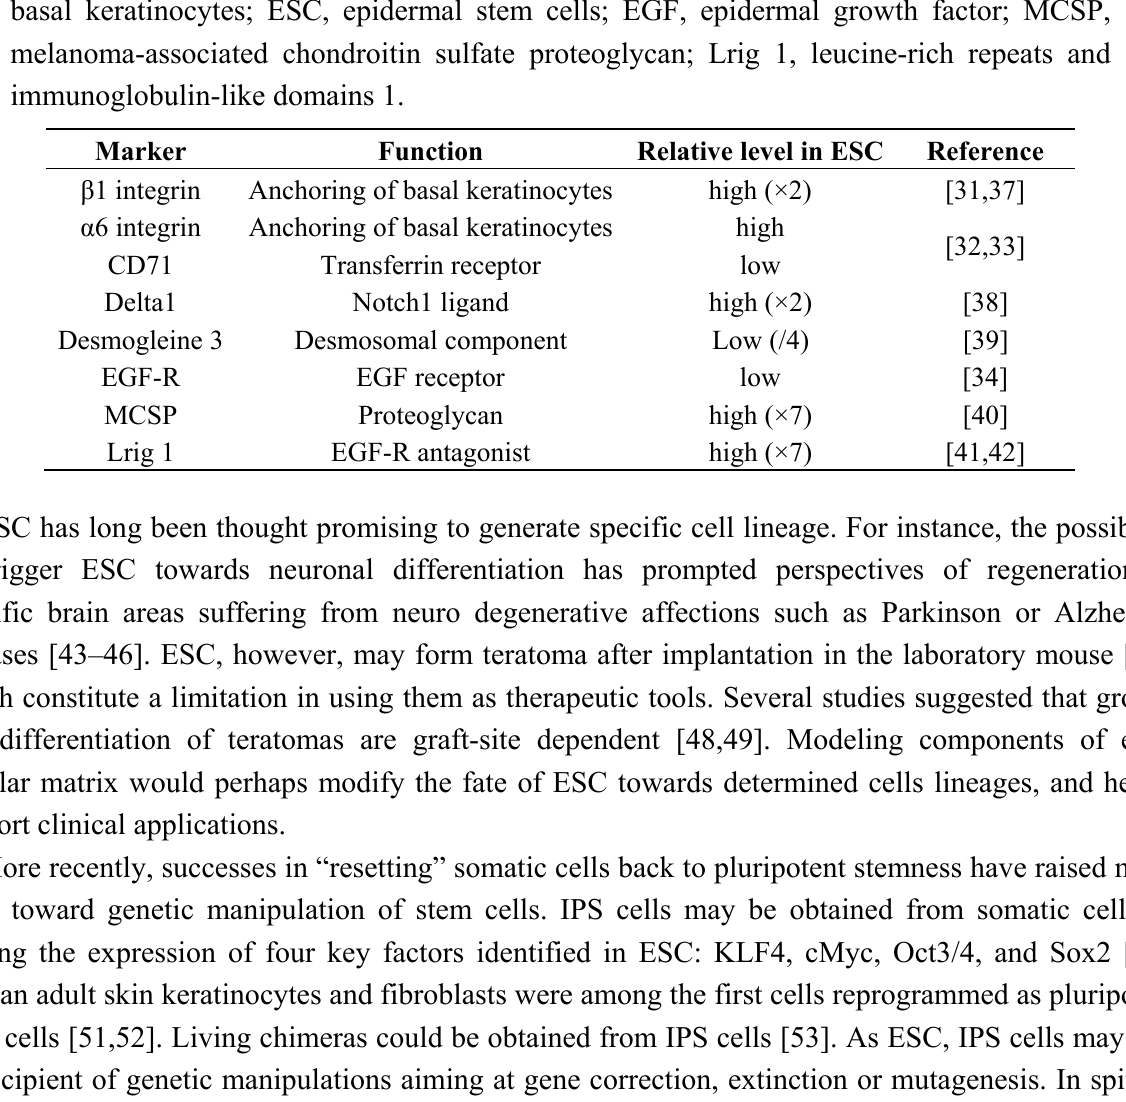
Table 1. Representative markers used for enrichment of stem cells of the interfollicular epidermis. High or low indicate levels of expression in stem keratinocytes relative to other basal keratinocytes; ESC, epidermal stem cells; EGF, epidermal growth factor;